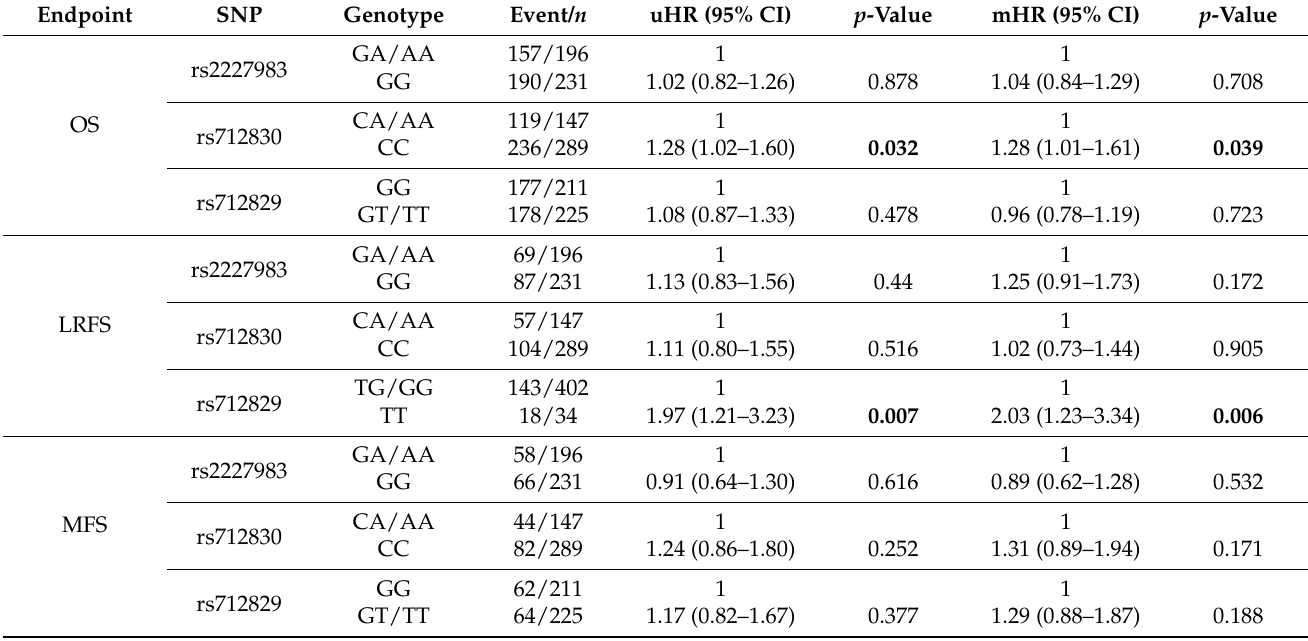
Table 2. Survival analysis according to individual SNPs in the whole group.